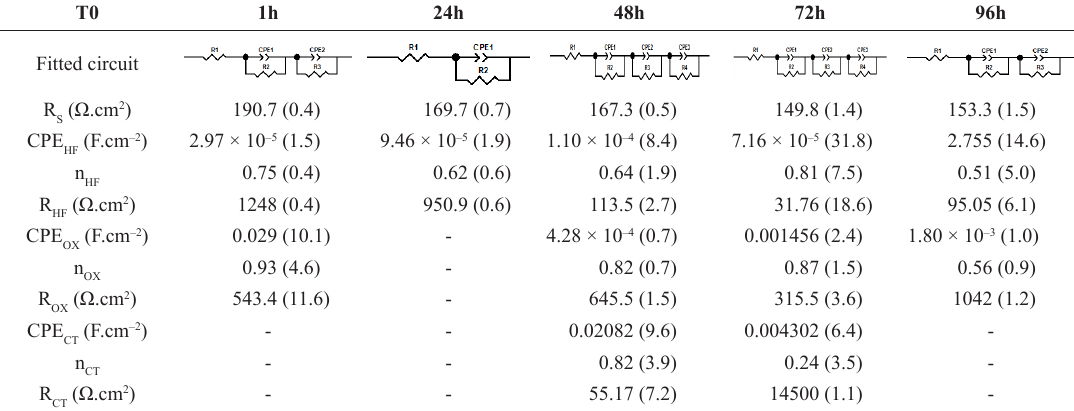
Table 5. Electrical elements fitted values for the T0 sample up to 96 hours of immersion in a 0.05 mol.L –1 NaCl solution. The error percentage associated with each parameter value is given in parenthesis. T0 1h 24h 48h 96h Fitted